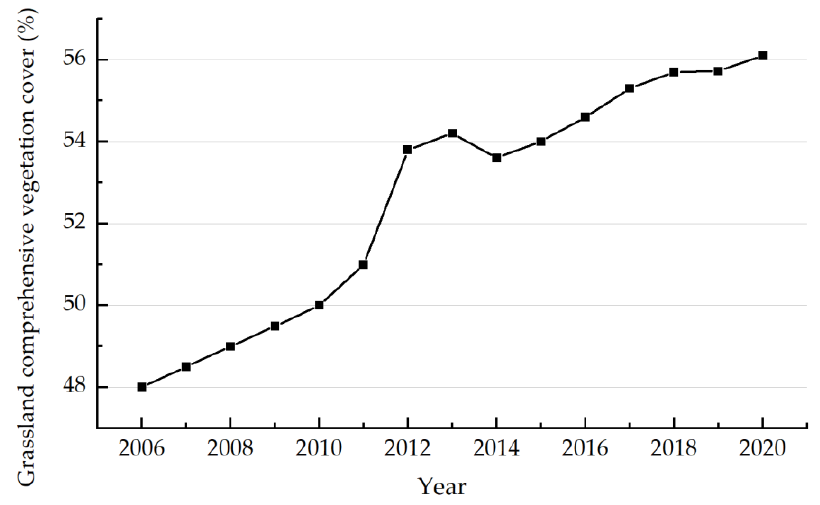
Figure 2. National grassland comprehensive vegetation cover.